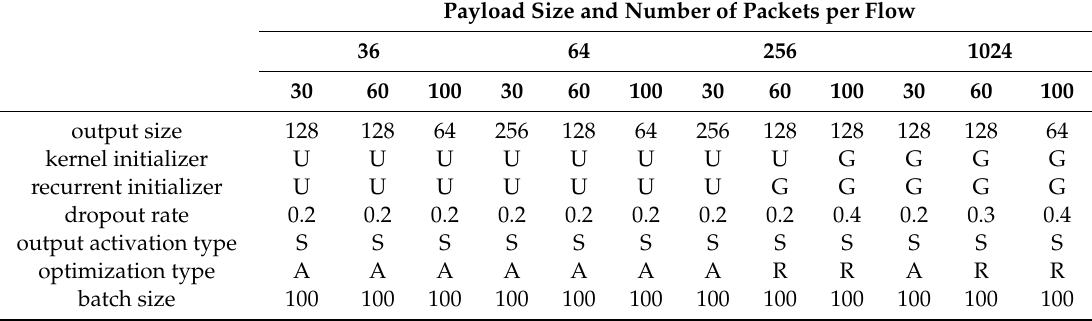
Table 3. The optimal hyper-parameter values for the multi-layer LSTM model (U: uniform, N: normal, G: glorot uniform, S: softmax, R: rmsprop, A: adam).